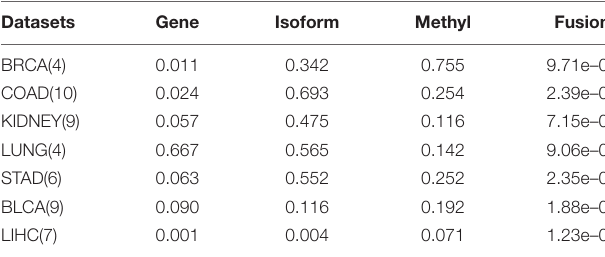
TABLE 3 | P -values of taking single kernel and fused kernel.